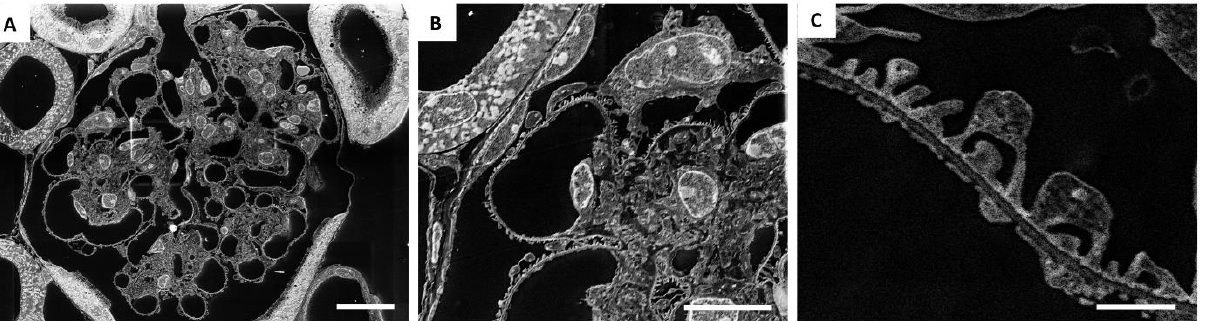
Figure 3. Application of SE–SEM method to image the kidney from the structural to the ultrastructural level: ( A ) representative SE–SEM images of the entire glomerulus at a very high resolution; ( B , C ) SE–SEM imaging provides detailed images of the renal ultrastructure at different magnifications. Scale bar represents 10 µ m for ( A , B ), and 1 µ m for ( C ). Panel ( B ) is an enlargement of panel ( A ).